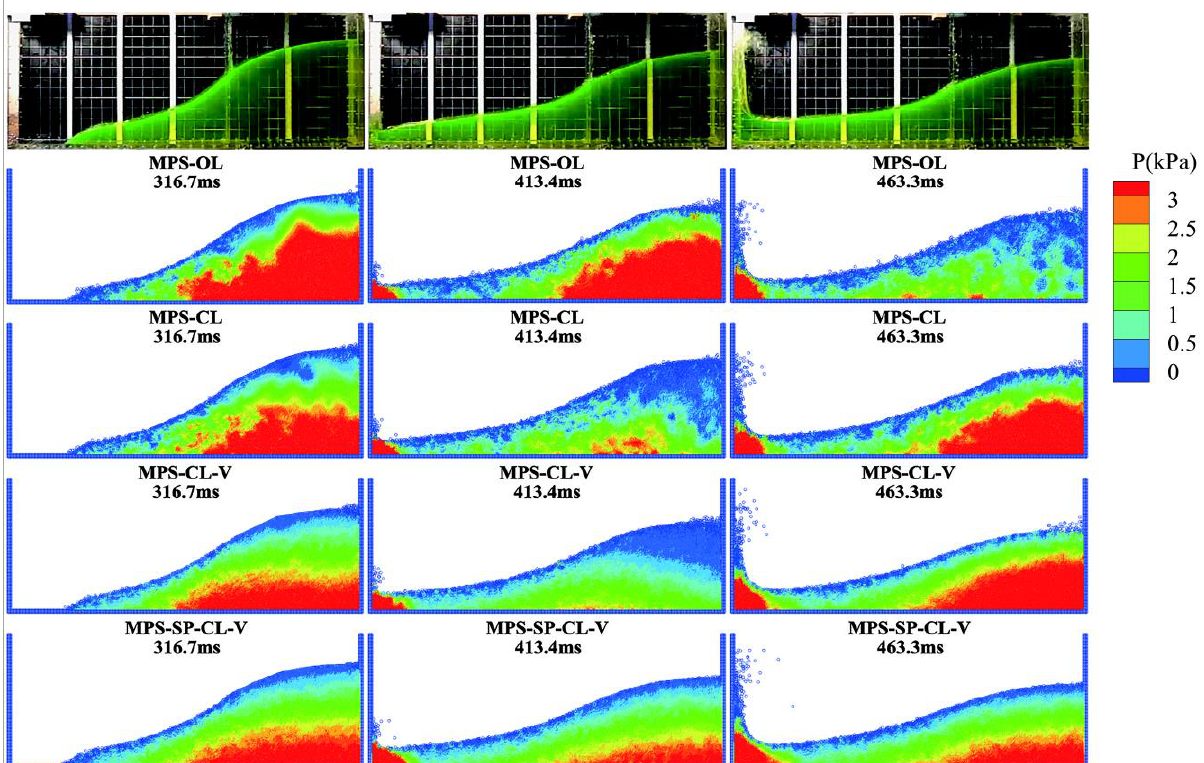
Figure 13. Particle distributions and pressure contours of dam-breaking fluid flows at t = 316.7 ms, 413.4 ms, and 463.3 ms.